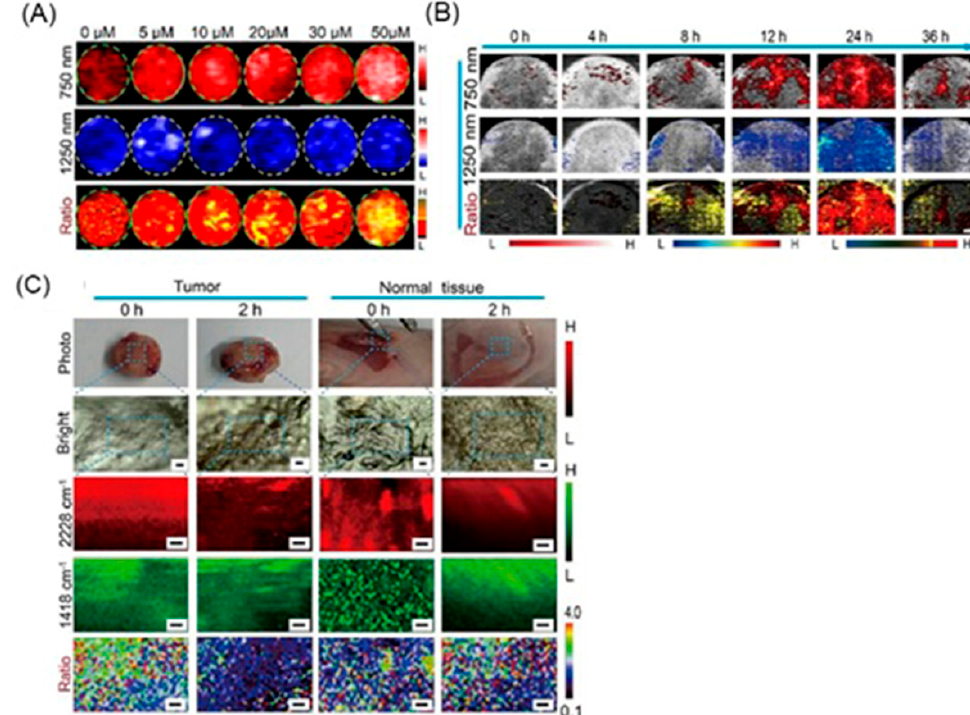
Figure 16. Representative in vitro and in vivo images. ( A ) Photoacoustic images at 750 and 1250 nm and the corresponding ratio images of the core-satellite with the changes of hydrogen peroxide con- centration. In the presence of hydrogen peroxide, the substrate loaded in the core–shell is converted to an oxidized form with an increased photoacoustic signal at 750 nm, while the signal at 1250 nm of the nanorod remains unchanged, forming the ratiometric PA 750 /PA 1250 signal. ( B ) Photoacoustic imaging at 750 and 1250 nm, and the corresponding signal ratio, of mice with subcutaneous 4T1 tumors at different times after intravenous injection of the nanoprobe (scale bar is 1 mm). ( C ) Confocal Raman imaging at 2228 cm − 1 (red color, change peak) and 1418 cm − 1 (green color, constant peak) and the ratio image ( I 2228 / I 1418 ) of normal and tumor tissues before and two hours after injection of the nanoprobe (scale bar is 10 µ m). Adapted with permission from Li, Q.; Ge, X.; Ye, J.; Li, Z.; Su,